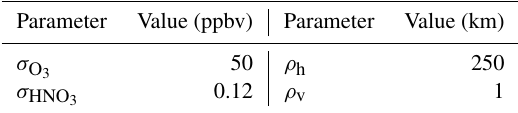
Table A1. Regularisation parameters for 3-D retrieval.